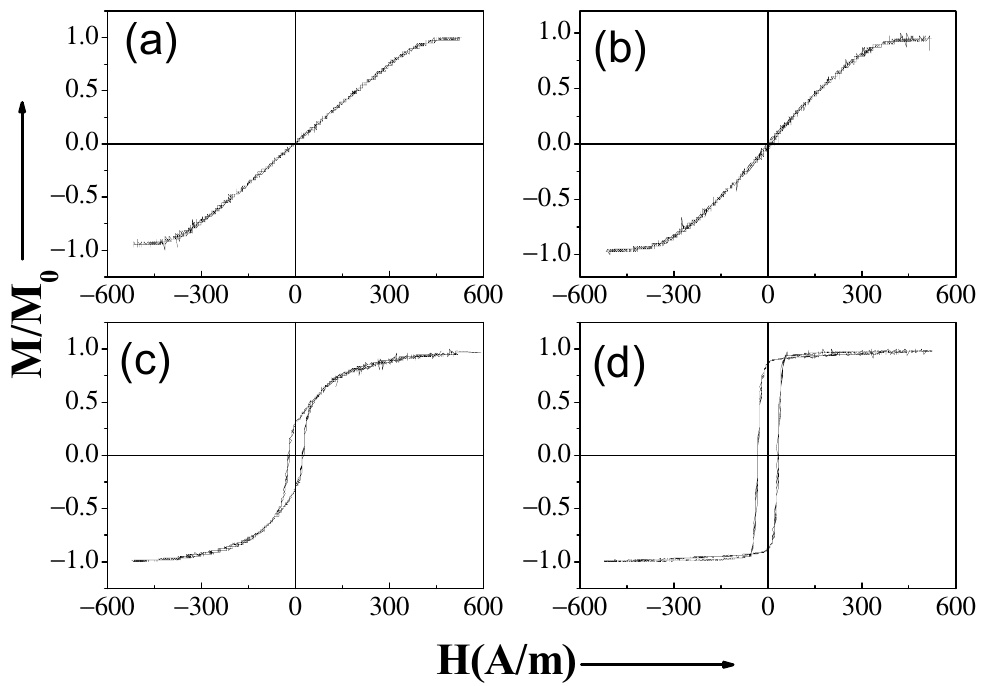
Figure 2. Hysteresis loops of as-prepared ( a ) and with chemically etched glass-coating for 5 min ( b ), 10 min ( c ) and 50 min ( d ) Co 70.5 Mn 4.5 Si 10 B 15 microwire. (Reproduced with permission from [65], Copyright © 2000 Elsevier).